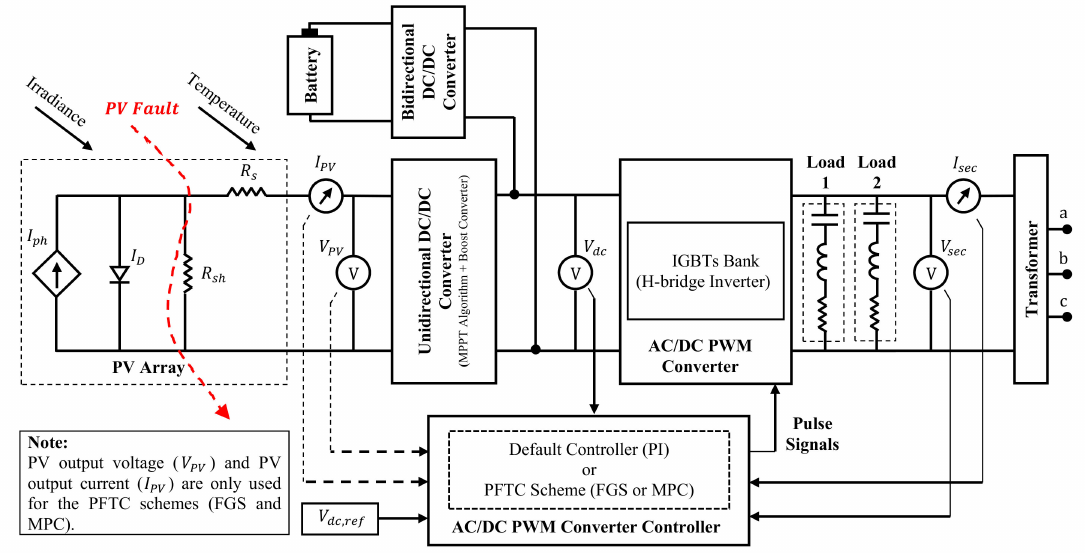
Figure 4. Schematic of the microgrid’s DC